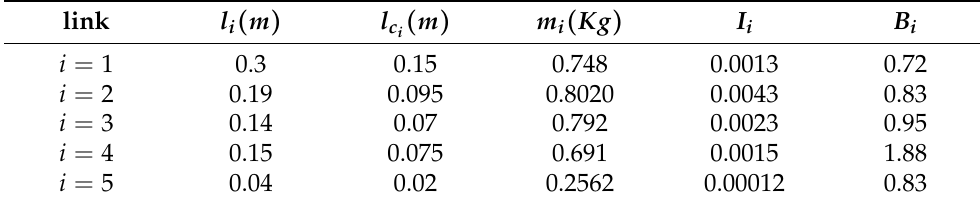
Table 1. Physical features of the robotic